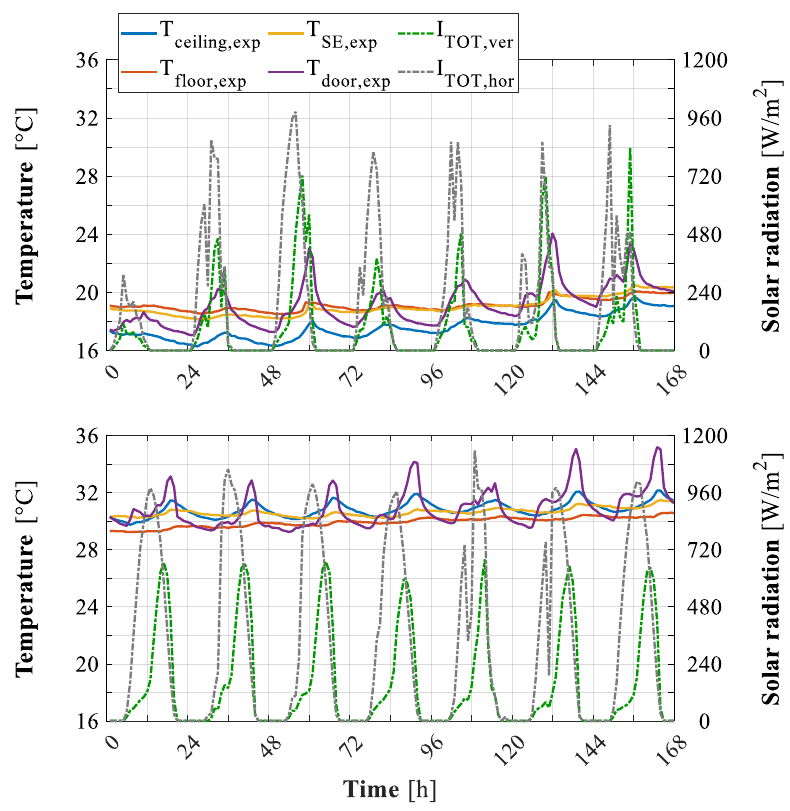
Figure 12. Time histories of the internal surface of the of the ceiling, floor, South-East wall and door and of the solar radiation incident on the vertical façade and on the horizontal roof—Sample winter week: March 23rd–29th ( top ) and sample summer one: July 1st–7th ( bottom ).